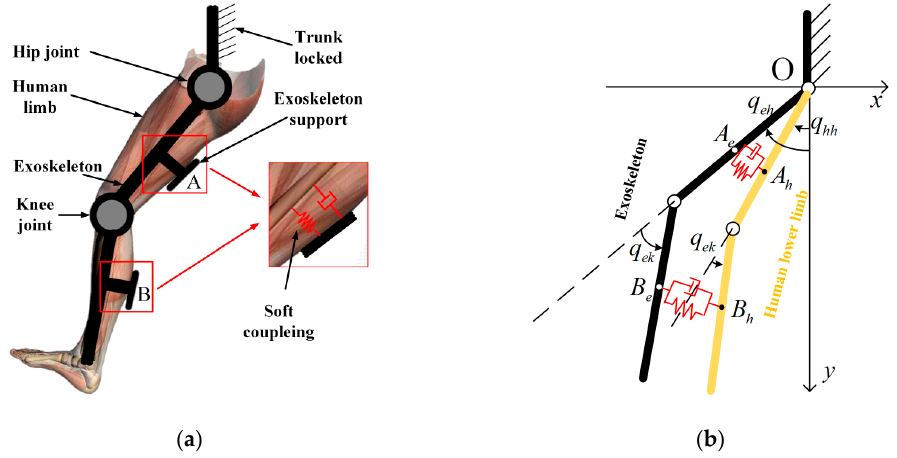
Figure 4. ( a ) The coupling model of human lower limb and exoskeleton. ( b ) The simplified model of the human lower limb (yellow) and the exoskeleton (black).